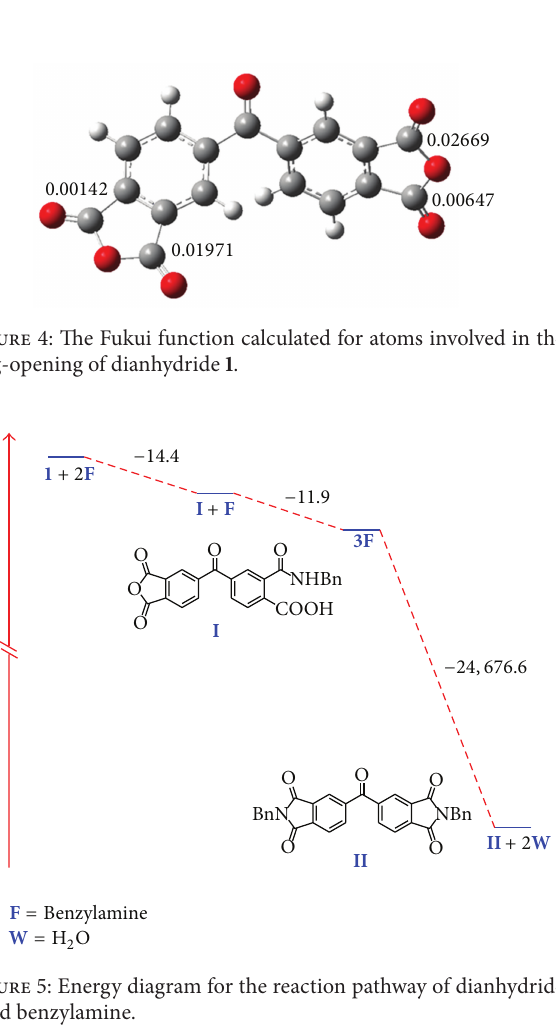
favors diimide formation only in small amounts (Figure 8).